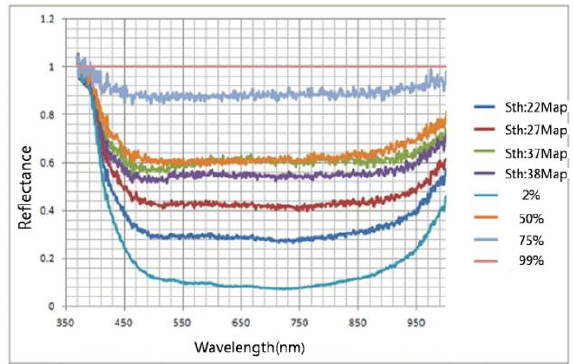
Figure 9. Spectral characteristics of reflectance panels and concretes extracted by VNIR camera